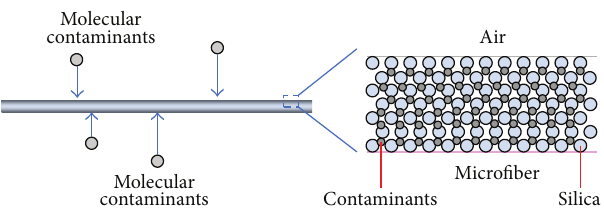
Figure 2: Principle of contaminants adhered to microfiber with nanoscale-structured film.